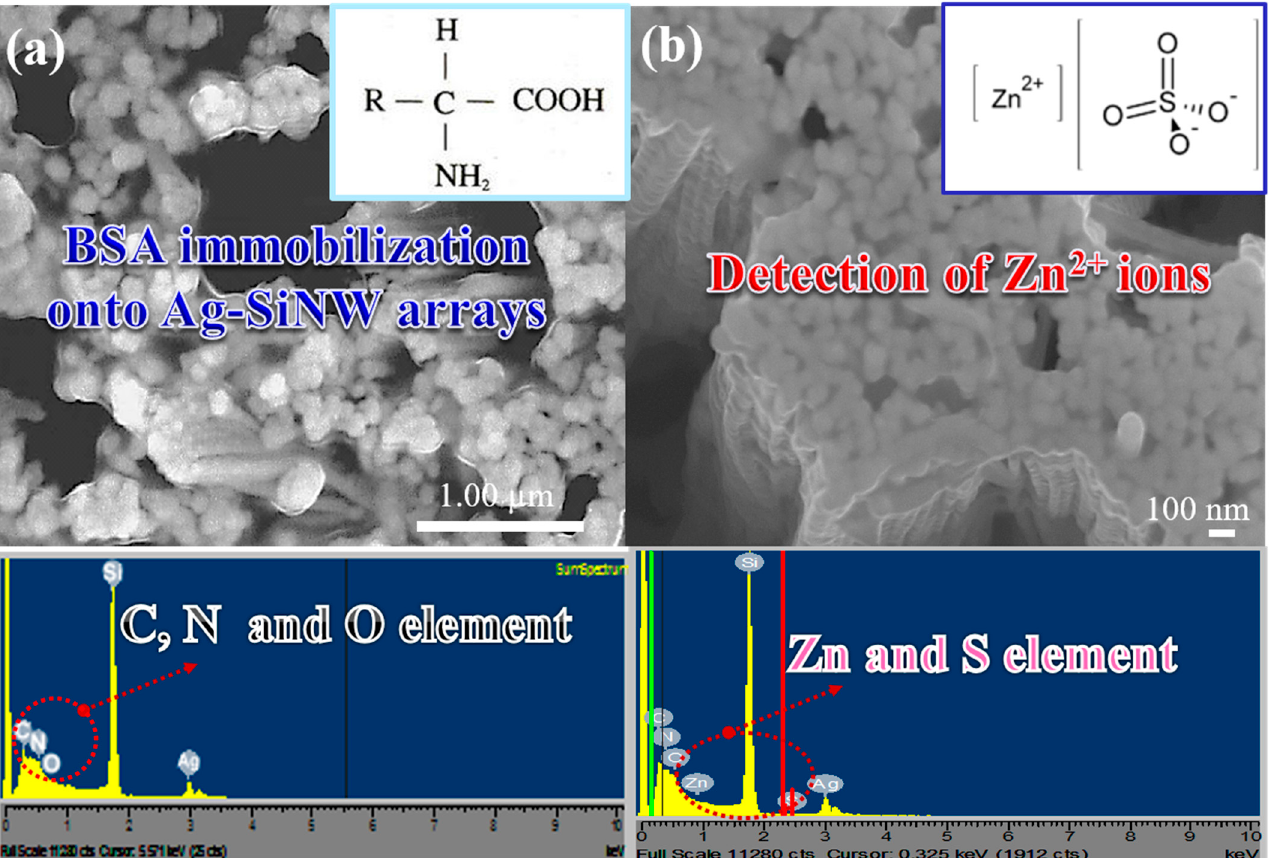
Figure 5. SEM images and EDS analysis of ( a ) the Ag–SiNW arrays immobilized with BSA and ( b ) the Ag–SiNW arrays after immobilizing BSA and ZnSO 4 .